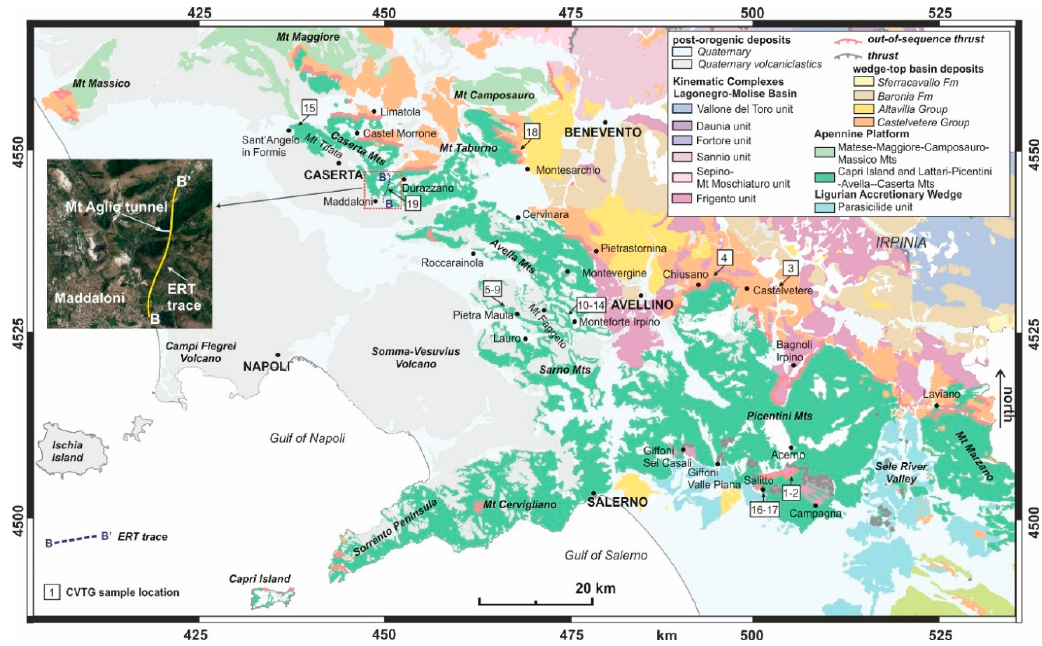
Figure 3. Tectonic map of the study area showing the analyzed sites and the trace of the electrical resistivity tomography (ERT) profile and tunnel excavation.